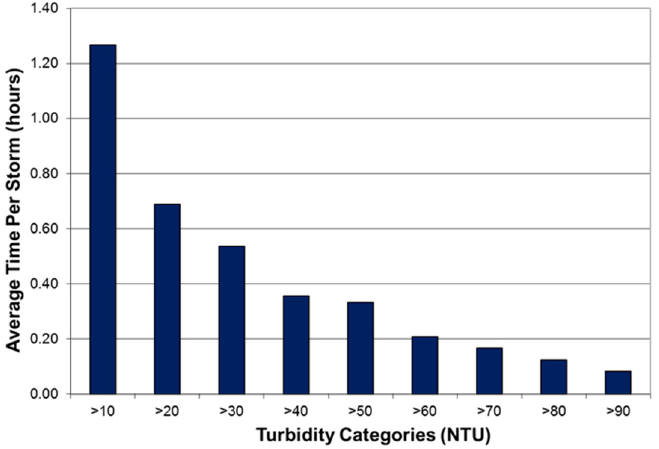
Figure 9. Average time turbidity was above a specified turbidity value at the Allen Creek #1 site between March 2007 and July 2010.